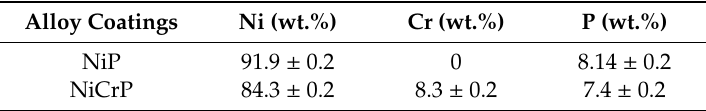
Table 1. Composition (wt.%) of the NiCrP amorphous alloy coatings.